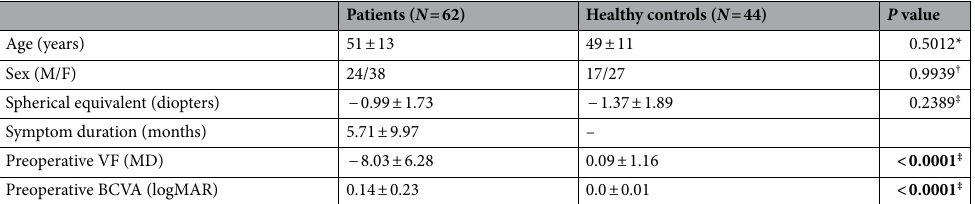
1: linear regression analysis between preoperative patients and healthy controls. P value 2: linear regression analysis between preoperative and postoperative